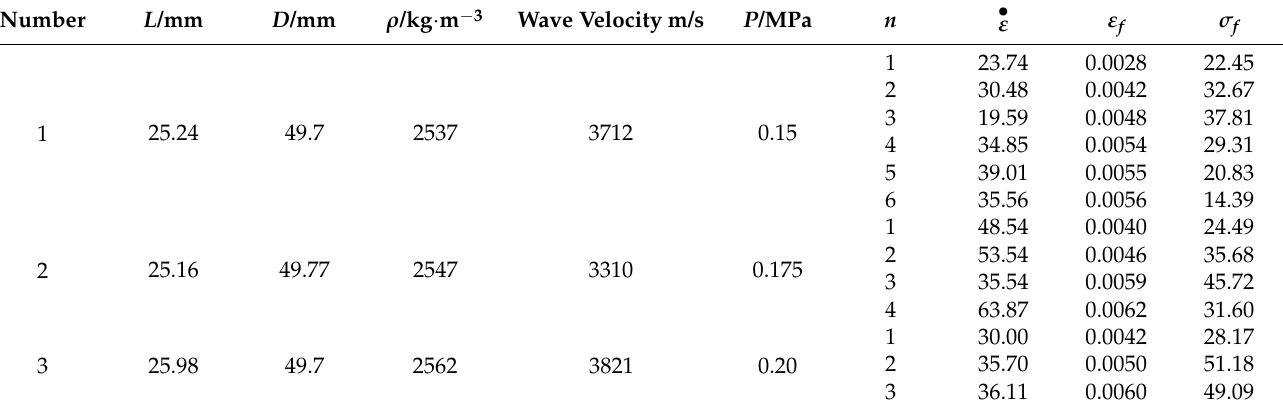
Table 2. Results of cyclic-impact